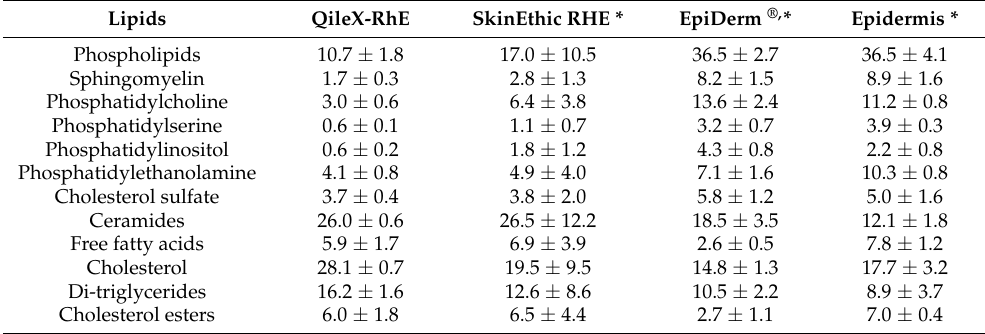
Table 2. Lipid composition of QileX-RhE, validated reference method and native epidermis. Lipids